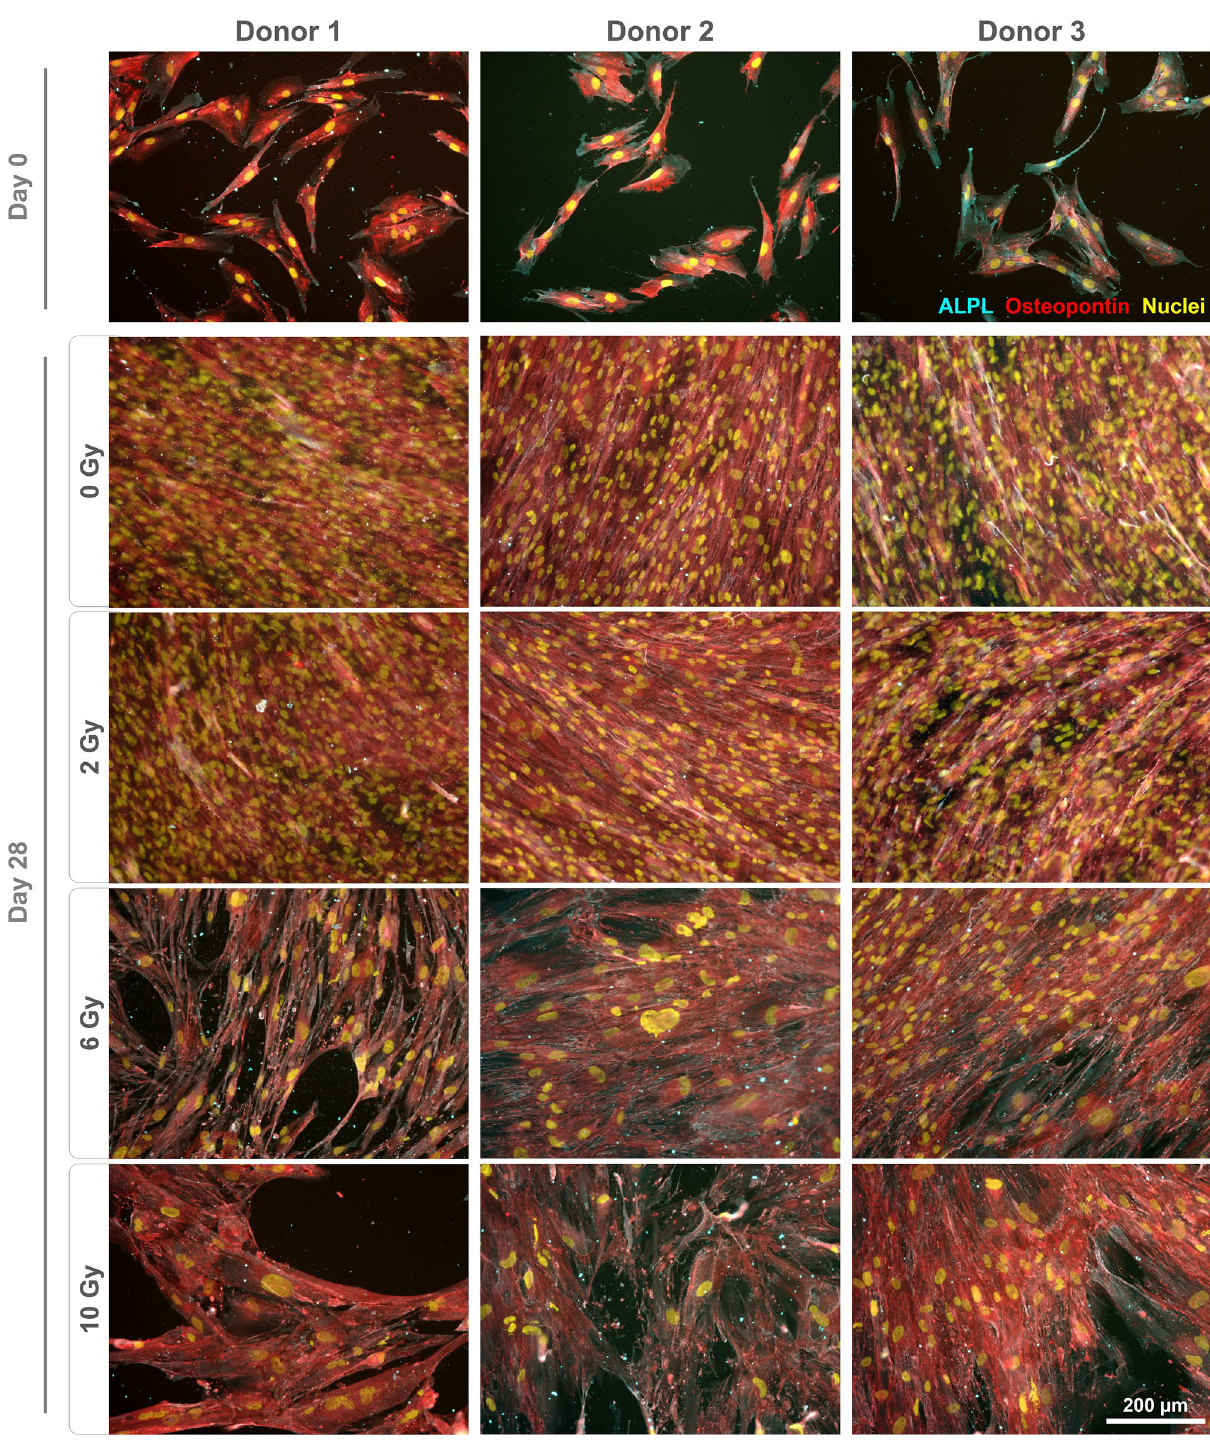
Figure 5. Immunostaining of irradiated JHOBs for ALPL and osteopontin. Cells were irradiated with 2, 6 and 10 Gy or sham, and stained for expression of ALPL (cyan) and osteopontin (red) after 28 days of cultivation in osteogenic medium. Non-treated cells on day 0 were used as a control. Nuclei were counterstained with DAPI